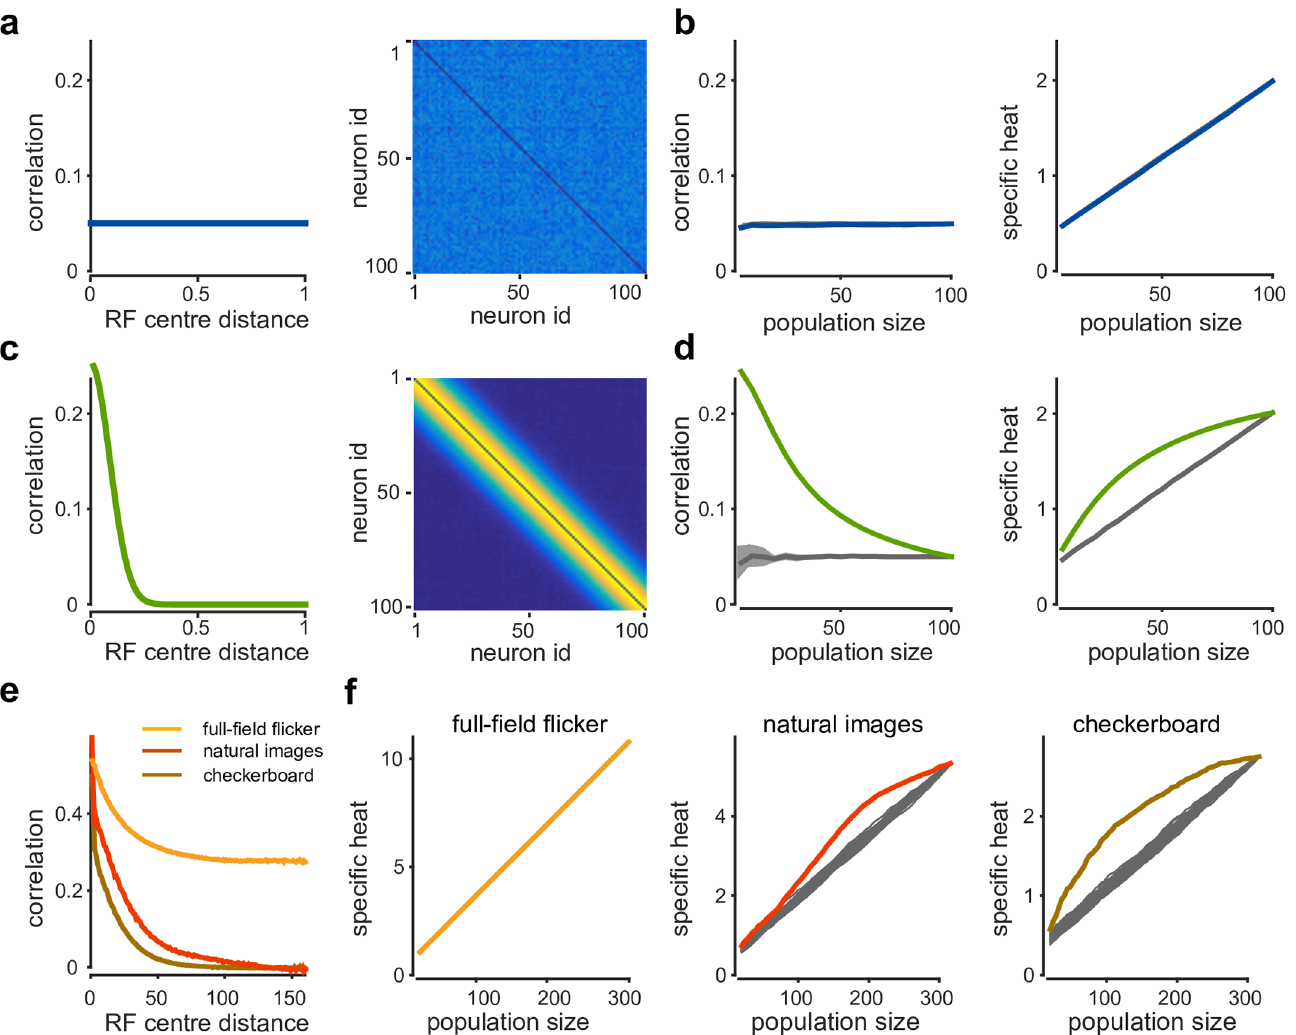
Fig 5. Random subsampling leads to criticality-inducing correlations. a) Illustration: A population with 100 neuronsand infinite-range correlations,the averagecorrelationbetweenany pair of neuronsis close to 0.05. Correlation as function of inter-neuron distance(left) and full correlationmatrix (right). b) Average correlationin subpopulation of different size n (left) and specific heat at T = 1 as function of n (right), when neurons are sampled from 1 to 100 (blue). Randomsamplinggives identicalresults (gray). c) Populationwith limited-range correlations, same plots as in panel a. d) Left: Average correlationas function of populationsize for spatiallystructured sampling(green)and uniform subsampling(gray). Right: Specific heat at T = 1 grows linearlyfor random subsampling, but shows signs of saturation for spatially structured sampling. e) Average correlation as function of inter-neuron distancein RGC simulation. For checkerboard and natural images, correlationsdrop to 0 for large distances. f) Specific heat at T = 1 for different stimulationconditions, for spatiallystructured (colour) or randomsubsampling(gray).